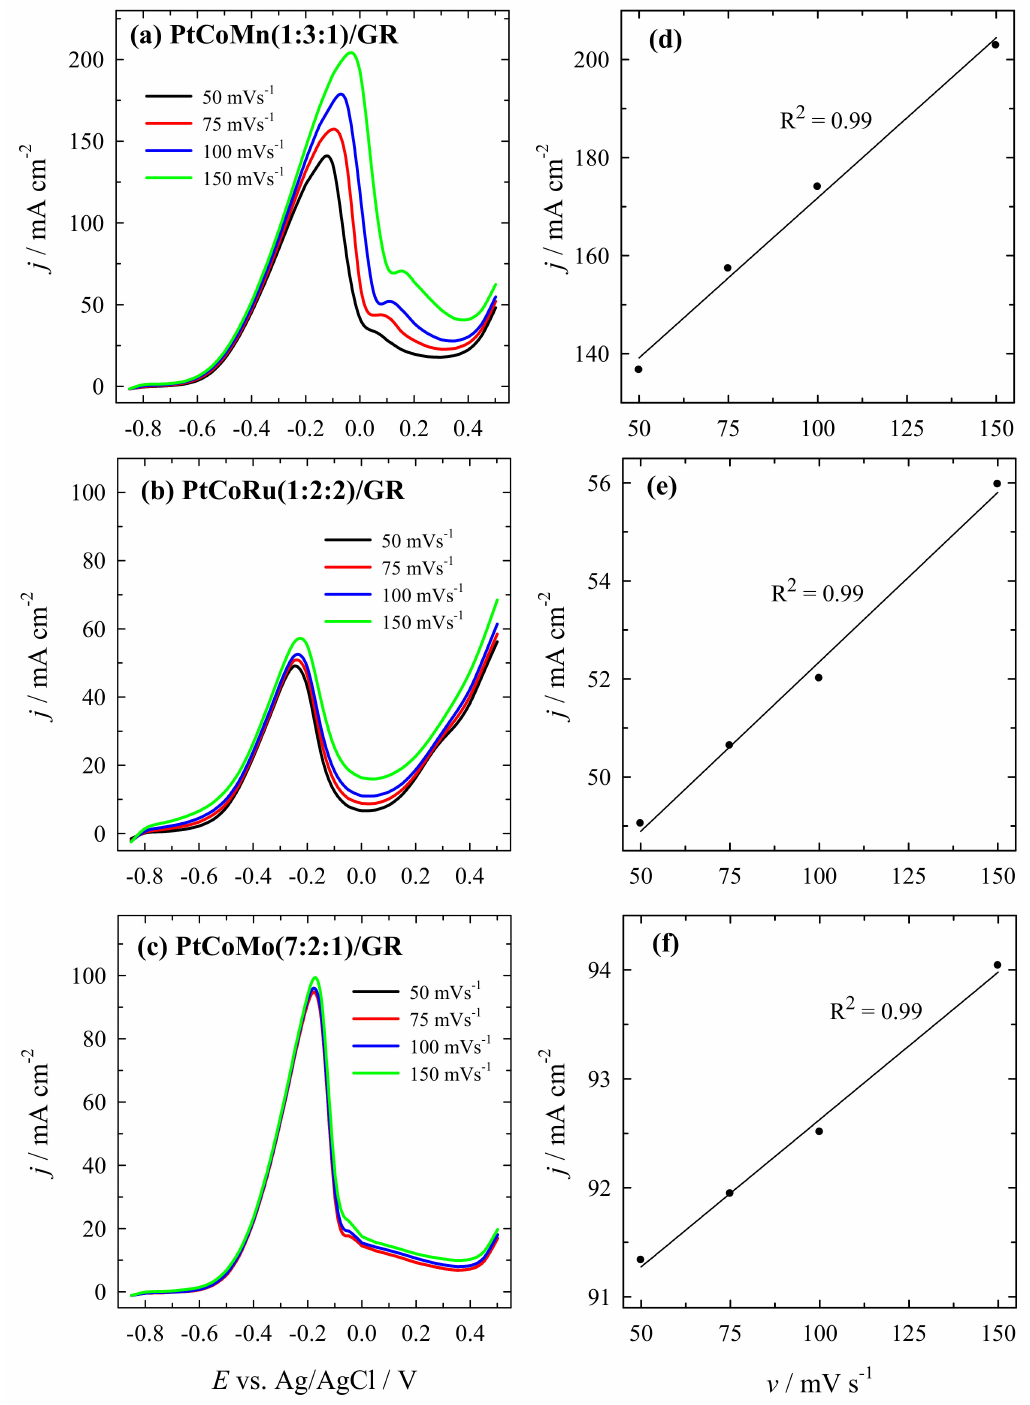
Figure 11. CVs recorded on PtCoMn(1:3:1)/GR, PtCoRu(1:2:2)/GR, and PtCoMo(7:2:1)/GR catalysts in a 1 M CH 3 OH + 1 M NaOH solution at different scan rates of 50–150 mV s − 1 ( a – c ); The relationship between the peak current densities and the square root of the scan rates ( d – f